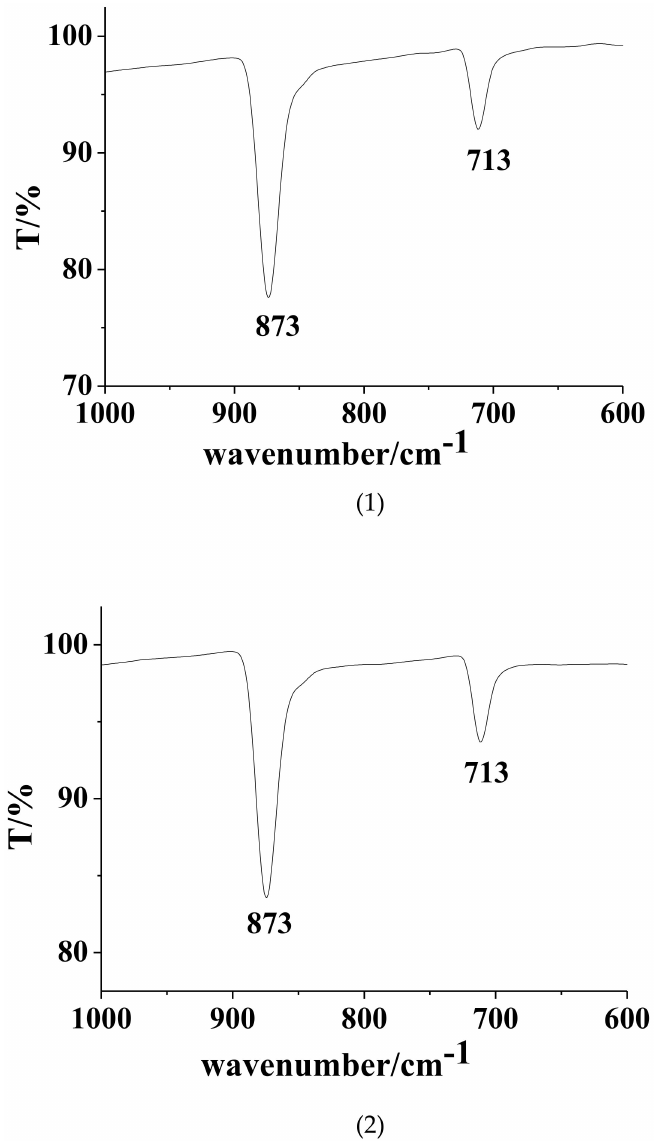
Figure 7. FTIR spectra of CaCO 3 crystals on the cathode surface in the scaling solution with 8 mg / L PBTCA, under di ff erent polarization potentials. ( 1 ) Polarization at − 1.0 V; ( 2 ) Polarization at − 1.5